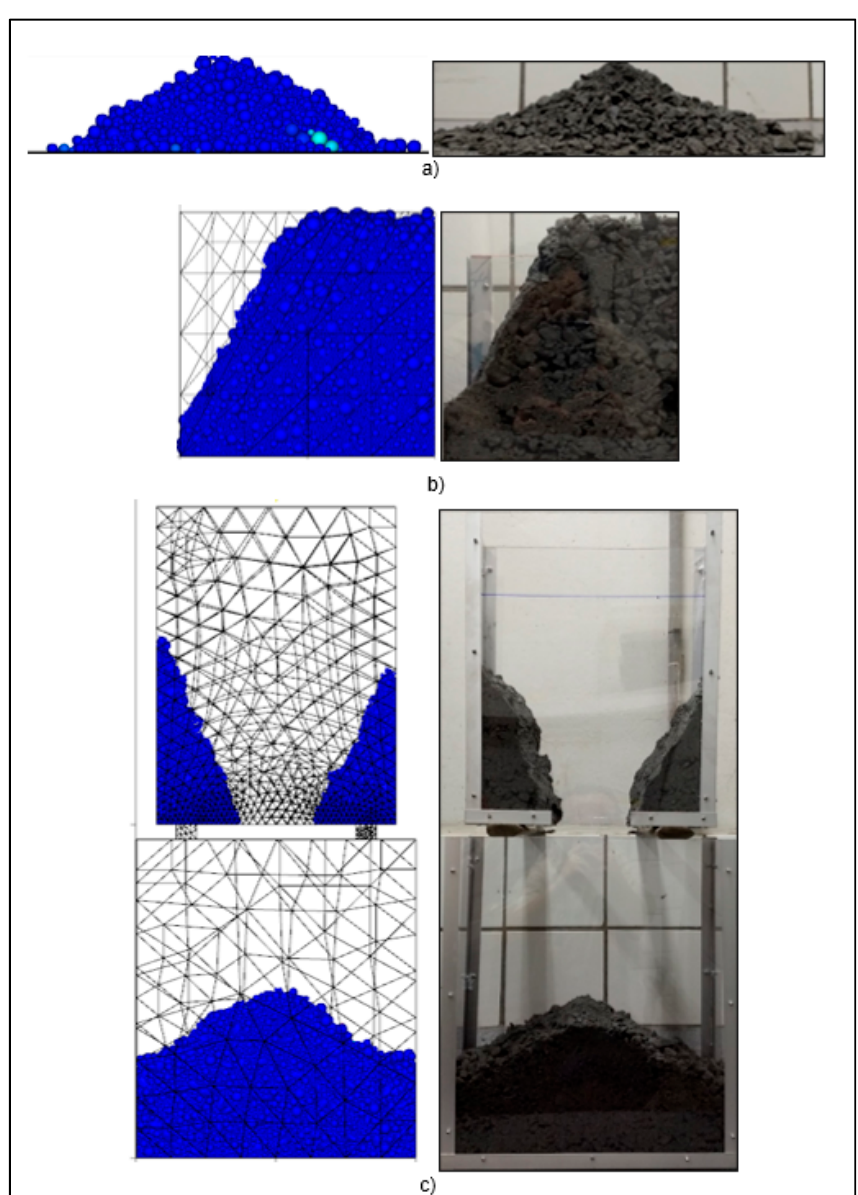
Figure 5. Comparison between laboratory test and DEM simulatons using calibrated contact parameters (Solution 2): ( a ) Lifting cylinder test, ( b ) Shear box test, and ( c ) Draw down test.